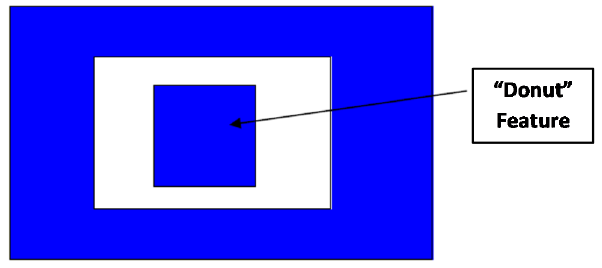
/ anchor feature in the SOIMUMPs Figure 3. Schematic of invalid doughnut/anchor feature in the SOIMUMPs process. Figure 3. Schematic of invalid doughnut